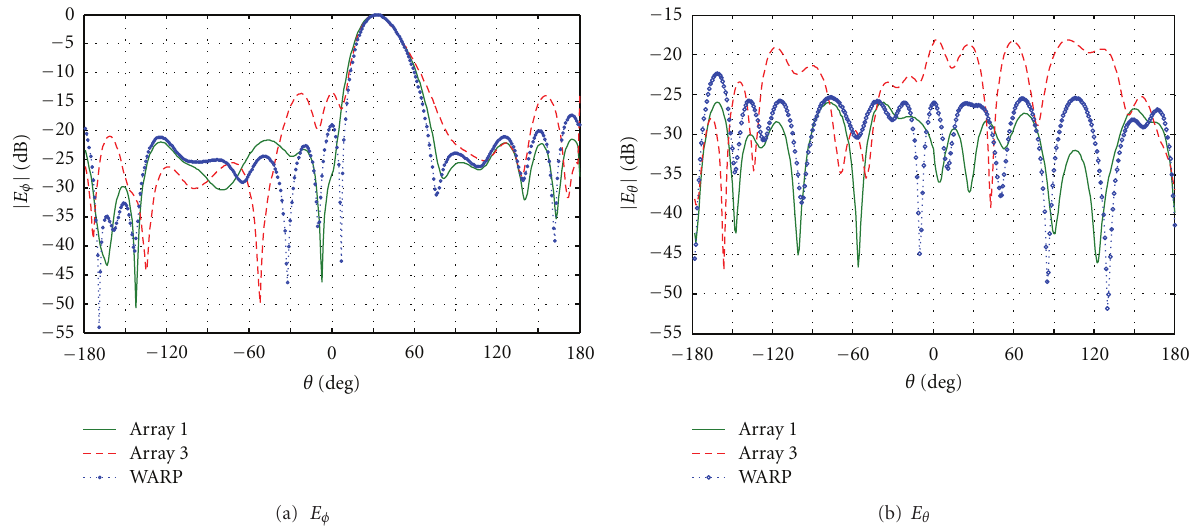
Figure 4: Comparison of the realized pattern using hybrid, nonhybrid, and WARP methods in the planes ϕ = 90 and ϕ = 270.